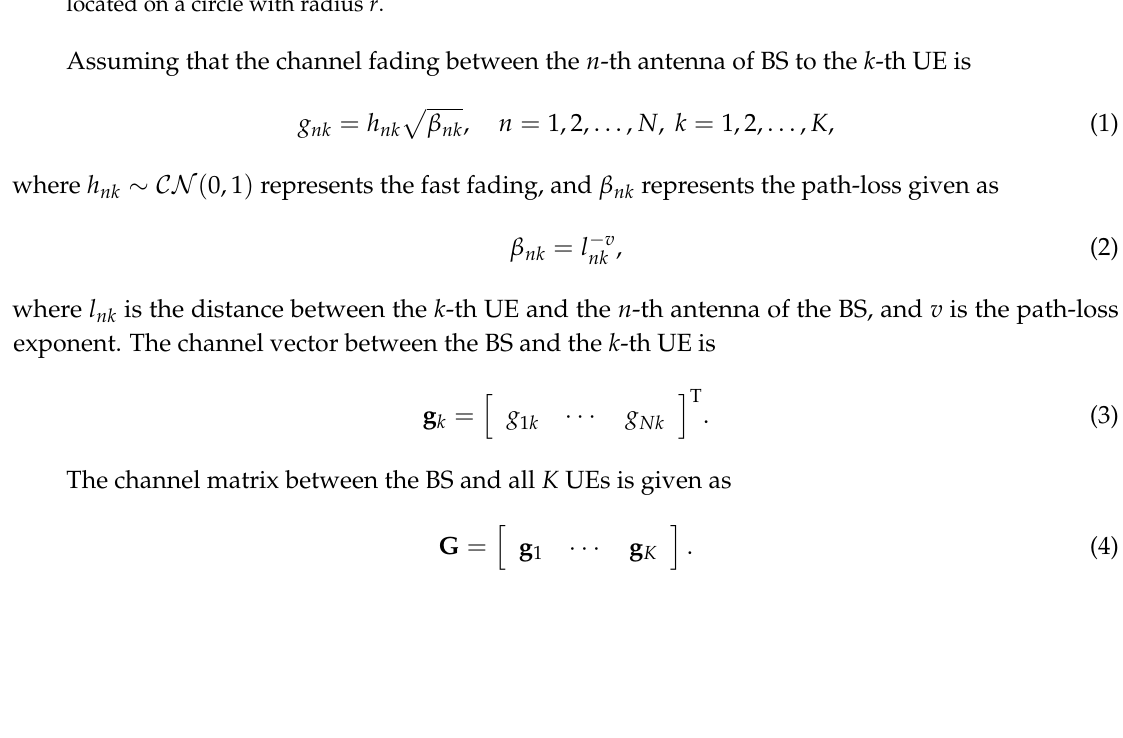
Figure 1. Massive multiple-input multiple-output (MIMO) system with circularly distributed antennas; K user equipments (UEs) simultaneously transmit signal to the base station (BS) with N antennas located on a circle with radius r